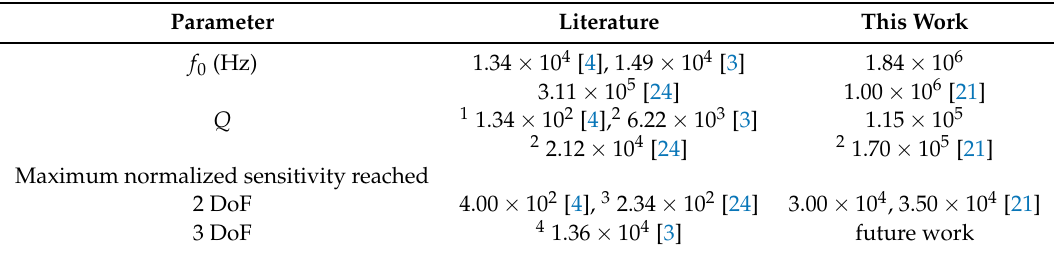
Table 2. Comparison of our hybrid sensor with a few devices using mode localization developed in different teams. Both a previous published work on a QCM of 1MHz RtF and those from this manuscript are presented